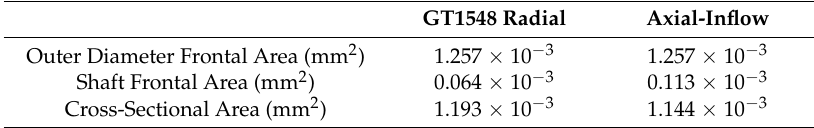
Table 15. Data comparison of the cross-sectional area of the GT1548 and axial-inflow turbines.